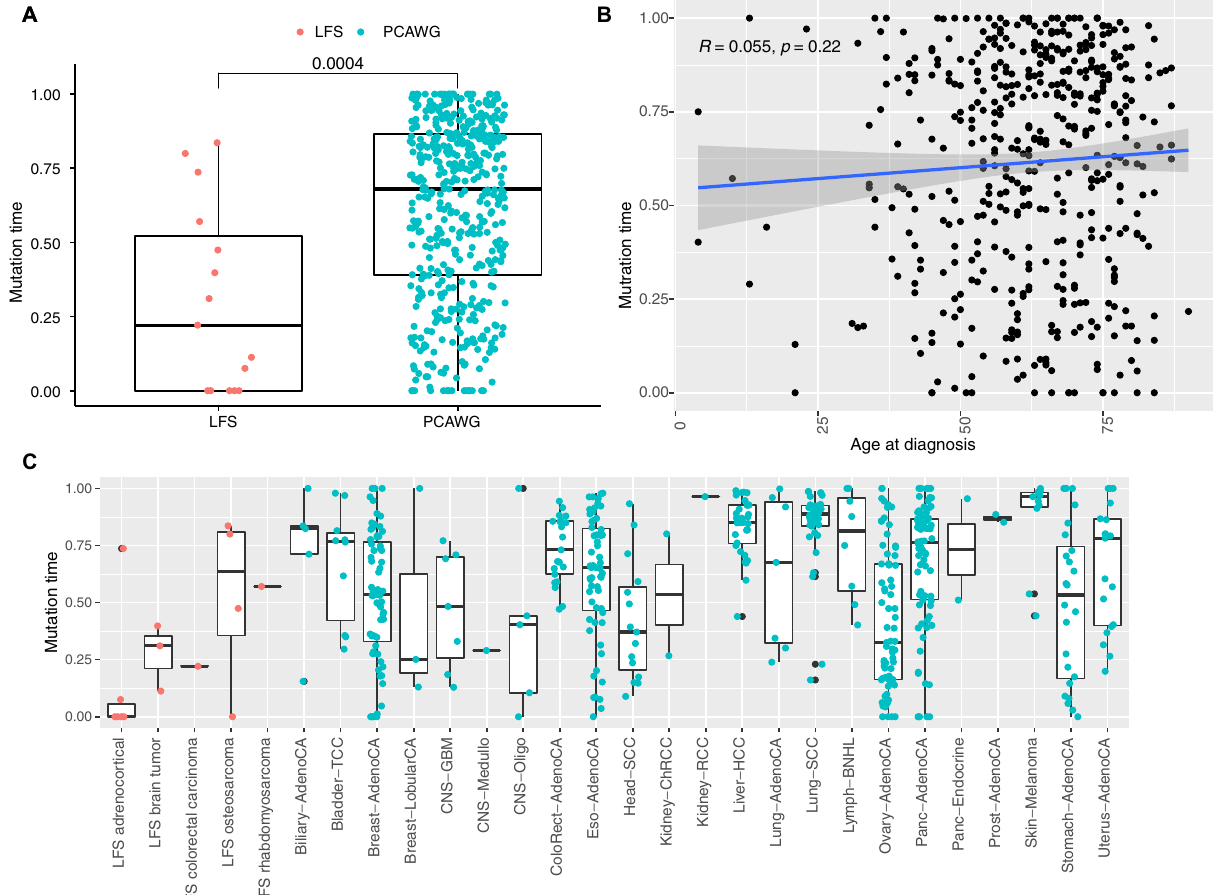
Fig. 4 | TP53 LOH occurs earlier in mutationaltime in LFS tumorsthanin TP53 somatic mutant tumors. A LFS tumors (left) and PCAWG TP53 somatic mutant tumors (right) plotted by TP53 LOH mutation time ( Y -axis). Wilcoxon 2-tailed p -value shown. Boxplots show quartiles with whiskers representing 1.5x inter- quartile range. N =501 biologically independent samples from distinct patients. B Age at diagnosis vs TP53 LOH mutation time for PCAWG TP53 somatic mutant